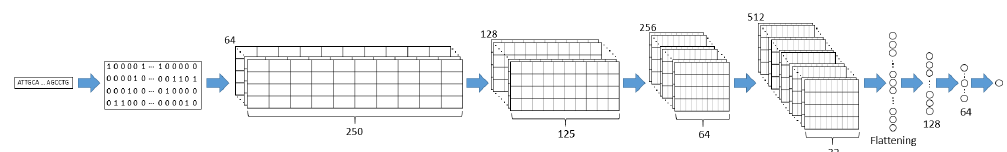
Figure 1. The network architecture of the CNN promoter prediction consists of four 1D-convolutional layers followed by a flattening layer and two fully-connected layers. At the end, an output layer with one neuron and a sigmoid activation function computes the probability that the analyzed sequence is classified as a promoter